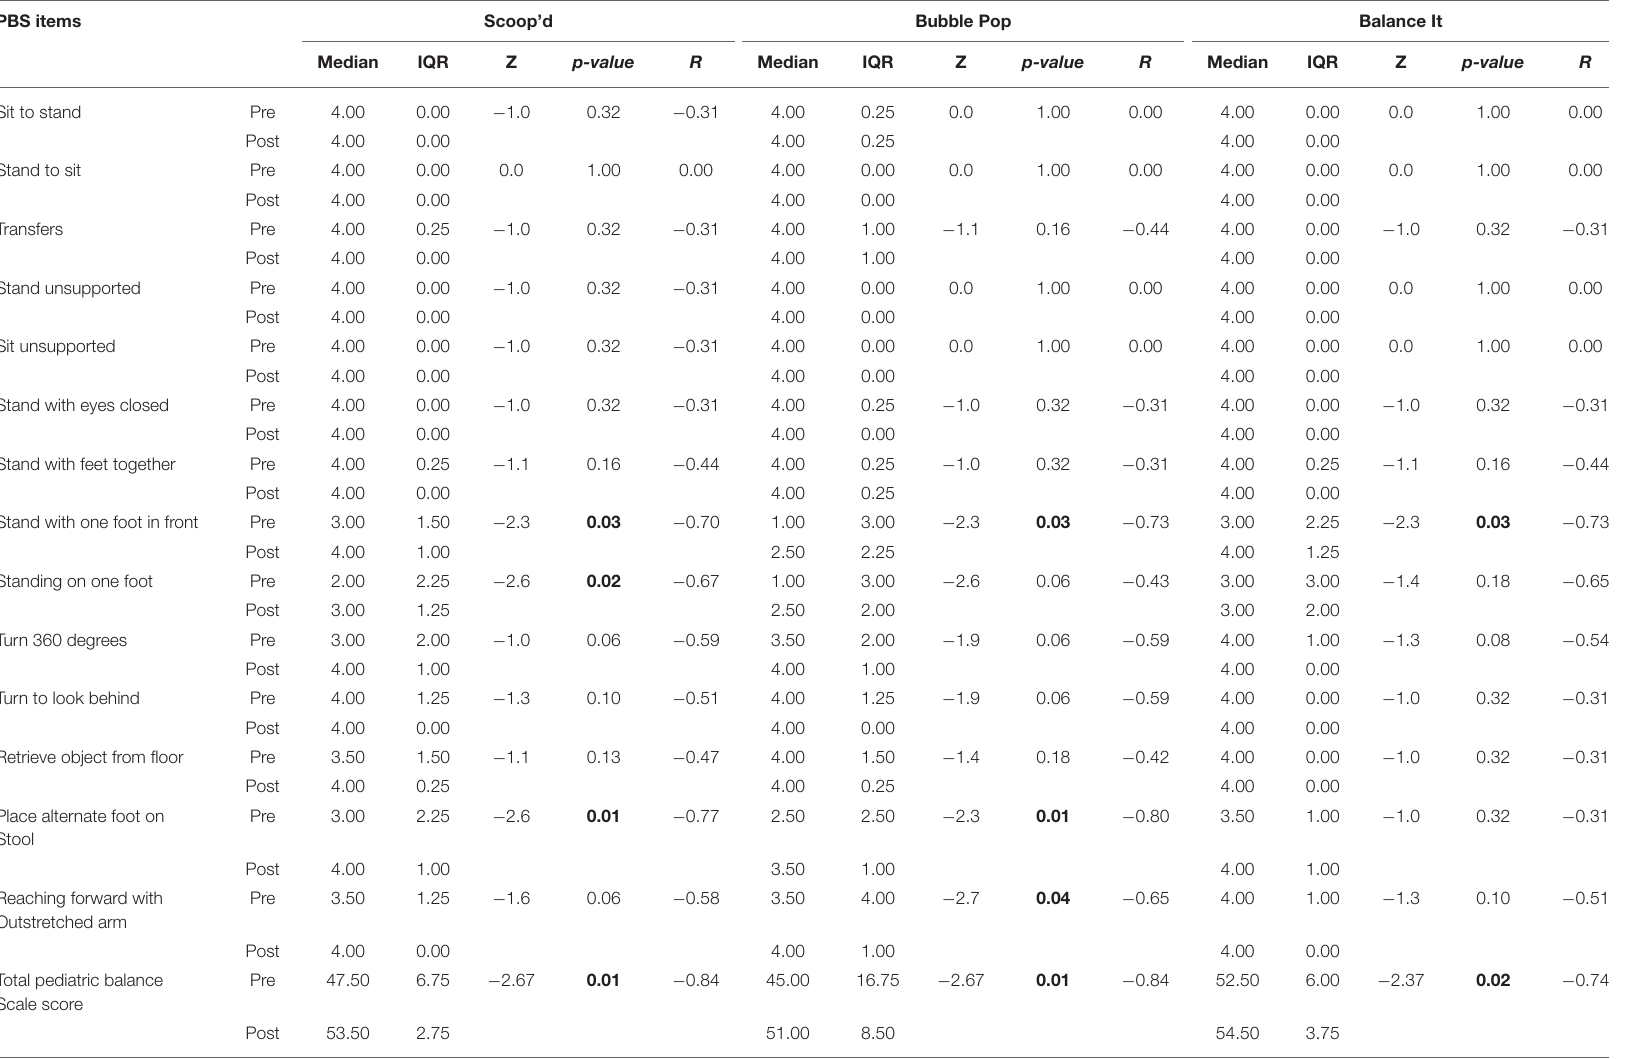
TABLE 2 | Pre-post analysis of PBS